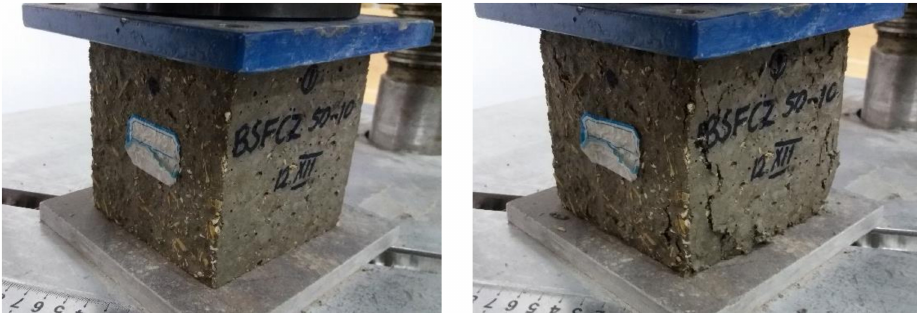
Figure 7. Composite specimen subjected to freeze-thaw cycles, before and after compressive strength testing.